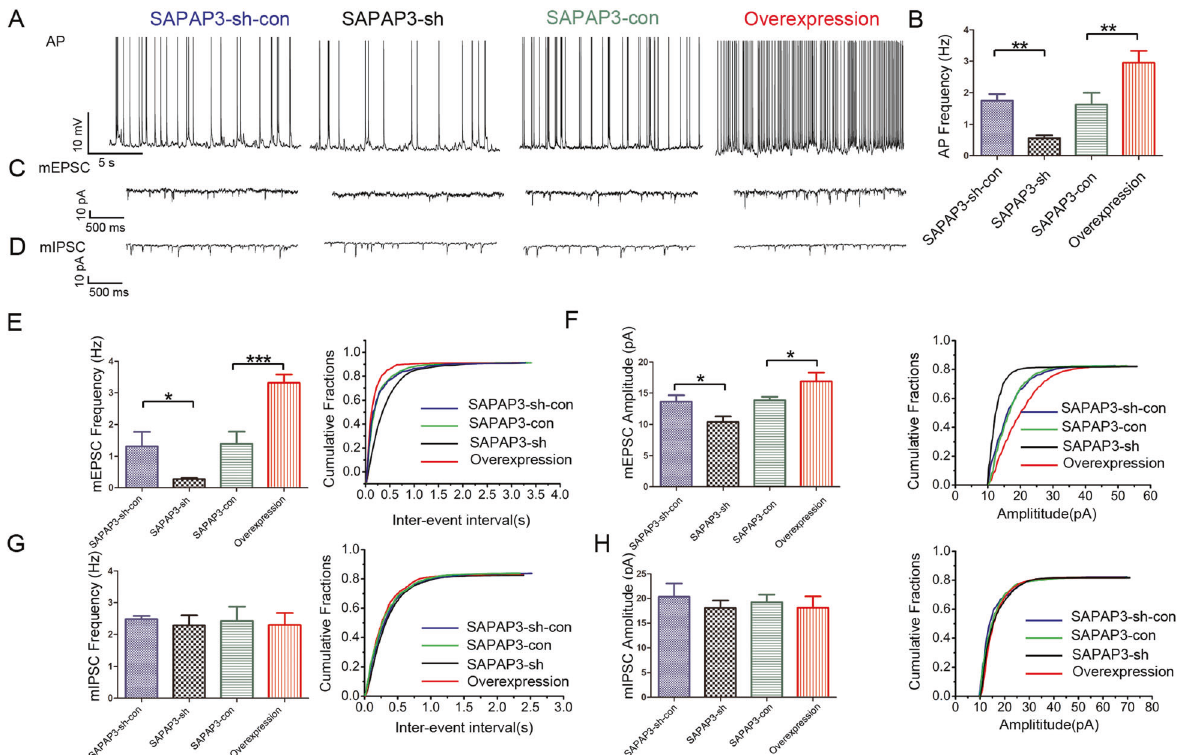
Fig. 4 Electrophysiological changes in hippocampal neurons in slices after SAPAP3 knockdown and overexpression. A , C , D Representative traces of APs, mEPSCs and mIPSCs in slices from mice treated with SAPAP3-sh-con, SAPAP3-sh, SAPAP3-con and recombinant SAPAP3 recorded in Mg 2 + -free ACSF. B Compared with the SAPAP3-sh-con group, the SAPAP3-sh LV signi fi cantly decreased the average frequency of APs. Compared with the SAPAP3-con group, the SAPAP3 overexpression LV signi fi cantly increased the average frequency of APs. SAPAP3-sh LV treatment signi fi cantly decreased the average frequency ( E ) and amplitude ( F ) compared with those of the control group and its representative cumulative fractions. SAPAP3 overexpression LV treatment yielded the opposite results ( E , F ). The data did not show a signi fi cant difference in the frequency ( G ) and amplitudes ( H ) of the mIPSCs among the groups. Data are presented as means ± SEM, n = 6 per group. * p < 0.05; ** p < 0.01; *** p <